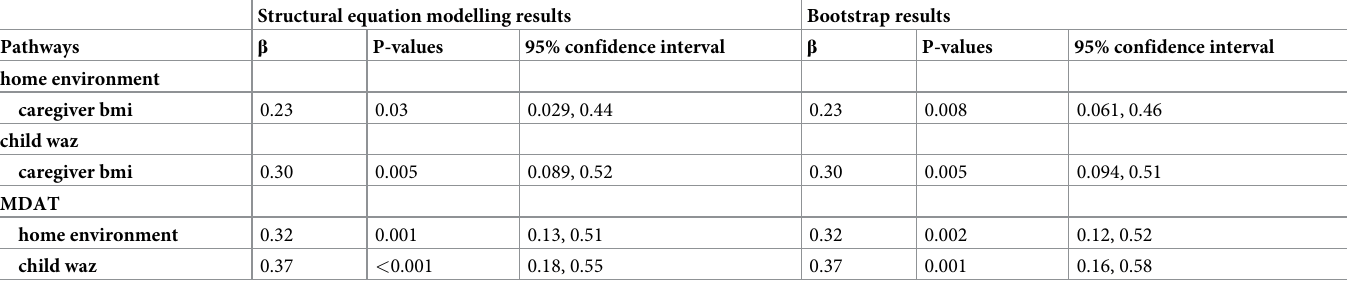
Table 3. Standardized beta-coefficients and bootstrap results for direct pathways between caregiver BMI, the home environment, child nutritional status according to WAZ, and development in children with SAM. Structural equation modelling